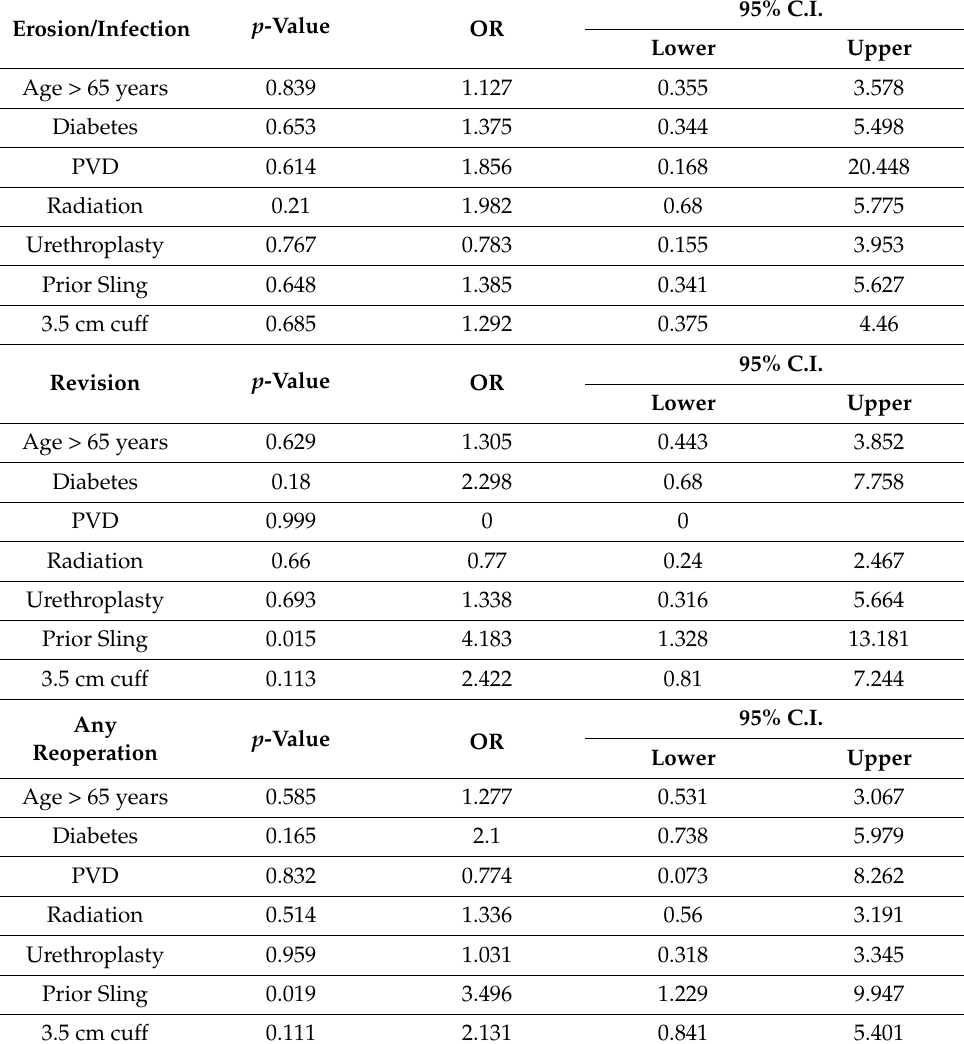
Table 4. Univariate